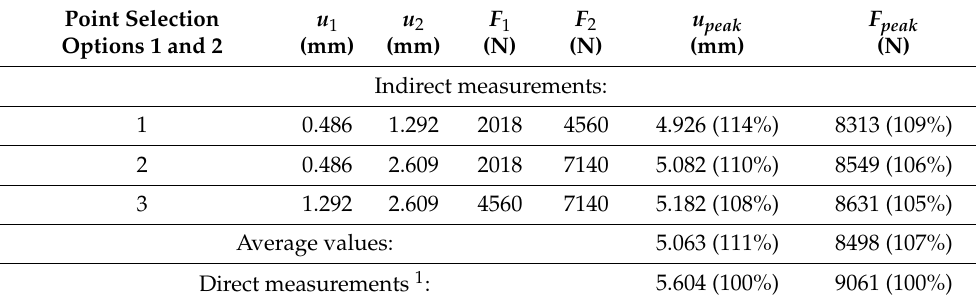
Table 2. Initial data ( u 1 , u 2 , F 1 and F 2 ) and the calculation results ( u peak and F peak